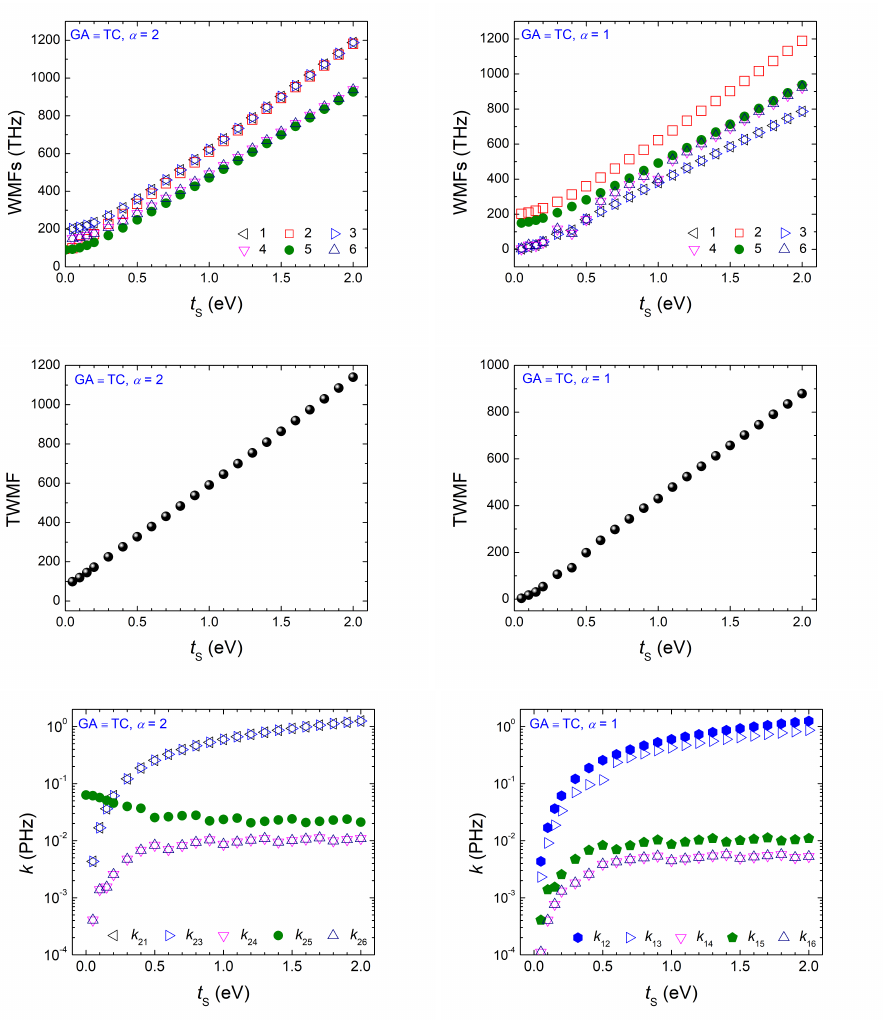
Figure A3. A dimer made of different monomers: GA ≡ TC dimer. Initial oxidation occurs either at the first base pair ( α = 2, left column ) or at the first deoxyribose ( α = 1, right column ). The mean-over-time probabilities to find the hole at each dimer site (first row), WMFs of all sites (second row), TWMF (third row), and transfer rates from site to site are presented as functions of t S